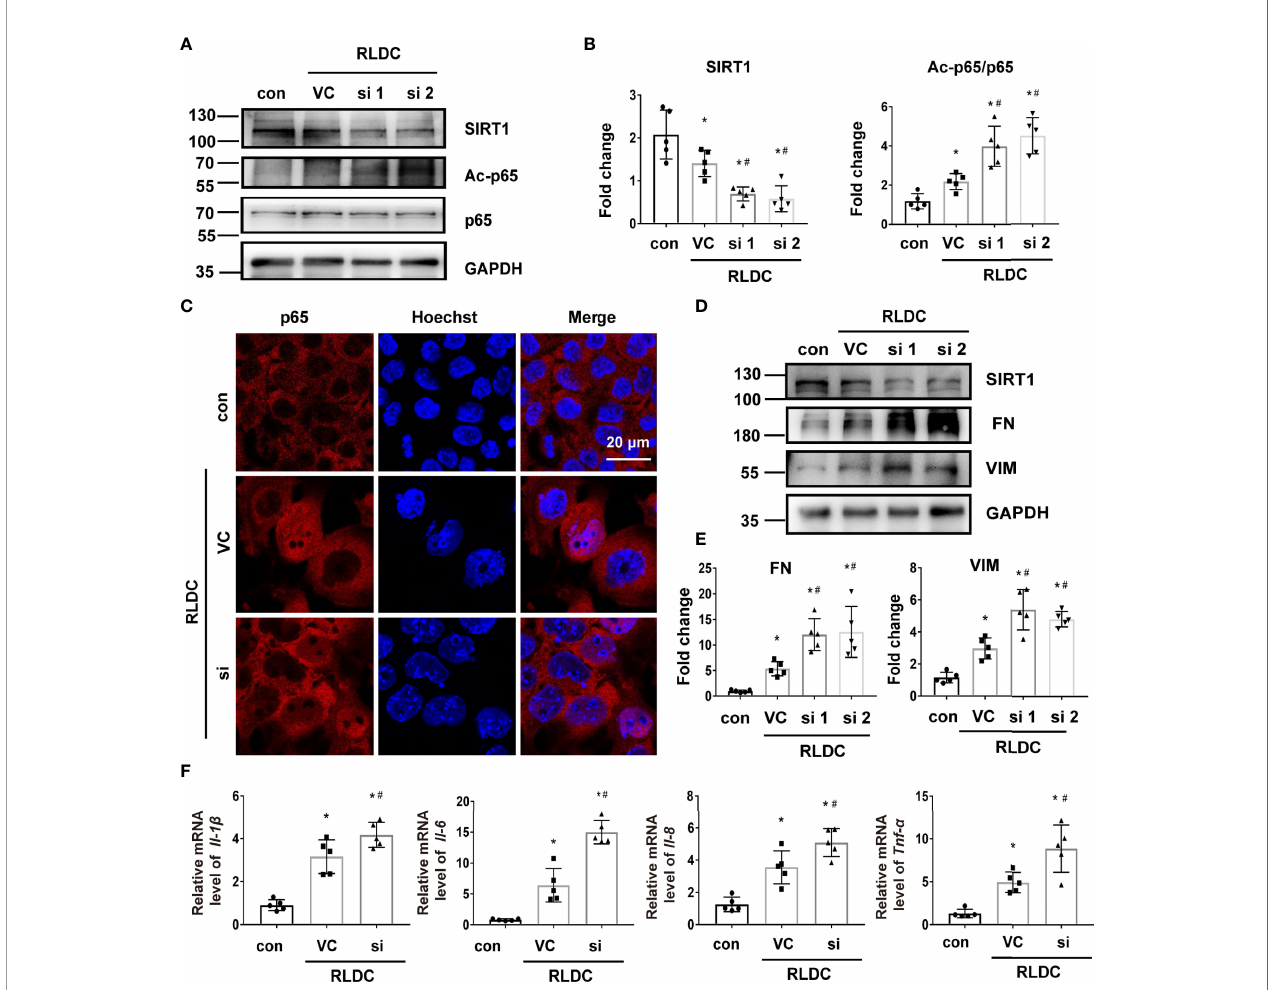
FIGURE 6 | Knockdown of SIRT1 increases p65 acetylation and the fi brotic phenotype of RLDC-treated renal tubular cells. BUMPT cells were transfected with 50nM SIRT1 siRNA1 (si1), siRNA2 (si2), or control siRNA (VC), and then incubated with 2 m M cisplatin for 7h each day for 4 days. (A) Representative immunoblots of SIRT1, Ac-p65, p65 and GAPDH (loading control) of total protein extracted from cells (n=5). (B) Densitometry of SIRT1 and Ac-p65. (C) Immuno fl uorescence analysis of nuclear translocation of p65. (n=5). (D) Representative immunoblots of SIRT1, FN, VIM and GAPDH (n=5). (E) Densitometry of FN and VIM. The protein level of control group was arbitrarily set as 1, and the signals of other conditions were normalized with it to indicate their protein fold changes. (F) mRNA levels of Il- 1 b , Il-6, Il-8, Tnf- a quanti fi ed by qRT-PCR (n=5). Data were normalized to Gapdh and expressed as fold change over controls. Data are expressed as mean ± SEM. *P<0.05 vs . the control group (Con), #P < 0.05 vs . RLDC with VC